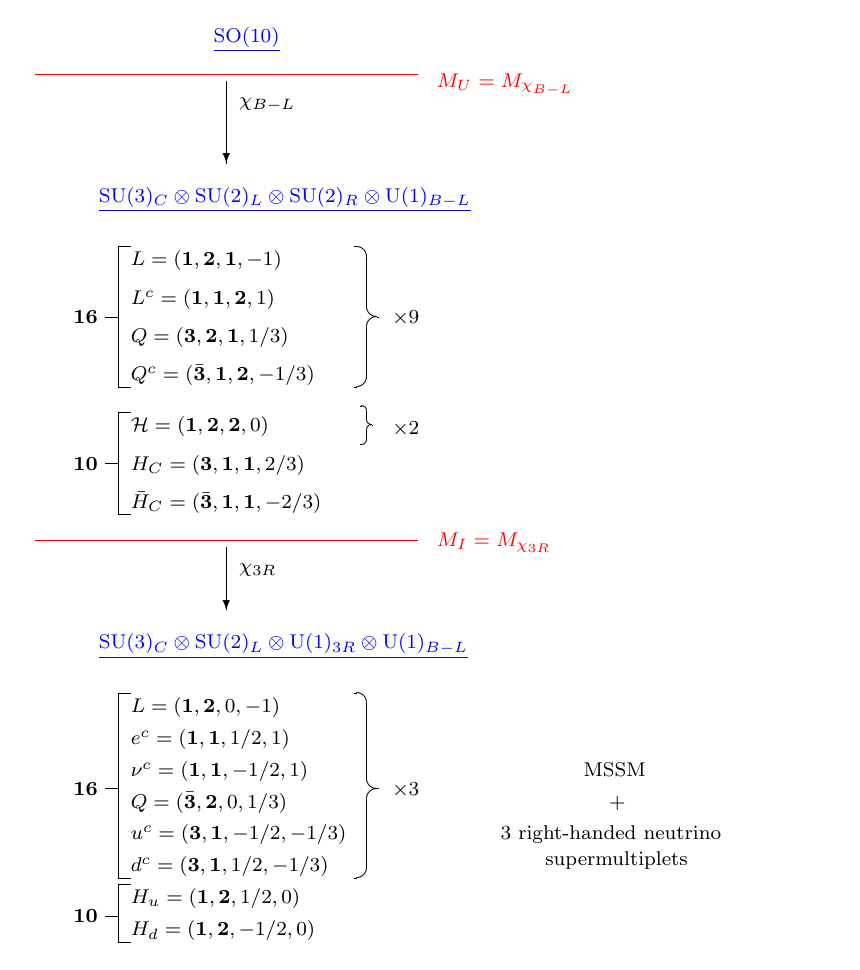
group of the standard model augmented by an additional U(1) B (cid:0) L Abelian symmetry.